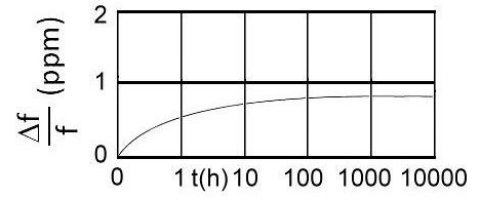
Figure 3. The quartz crystal frequency ageing